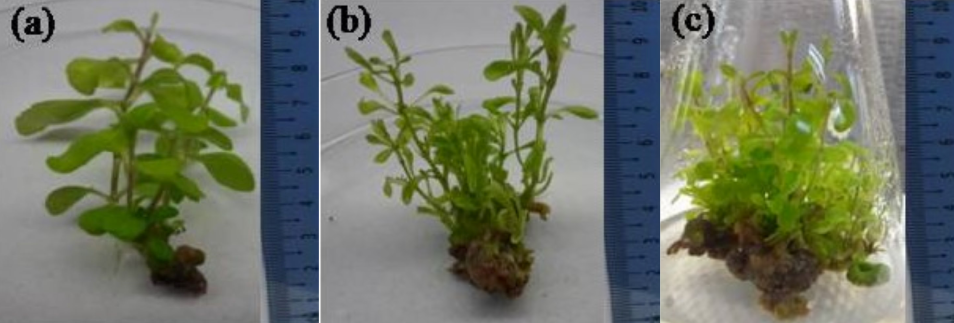
Figure 4. Regenerated shoots of stevia from induced calli on MS media supplemented with different concentrations of BAP and NAA at 30 DACI: ( a ) regenerated shoots on MS media with 1.00 mg/L BAP and 1.00 mg/L NAA; ( b ) regenerated shoots on MS media with 5.00 mg/L BAP and 0.00 mg/L NAA; and ( c ) regenerated shoots on MS media with 10.00 mg/L BAP.